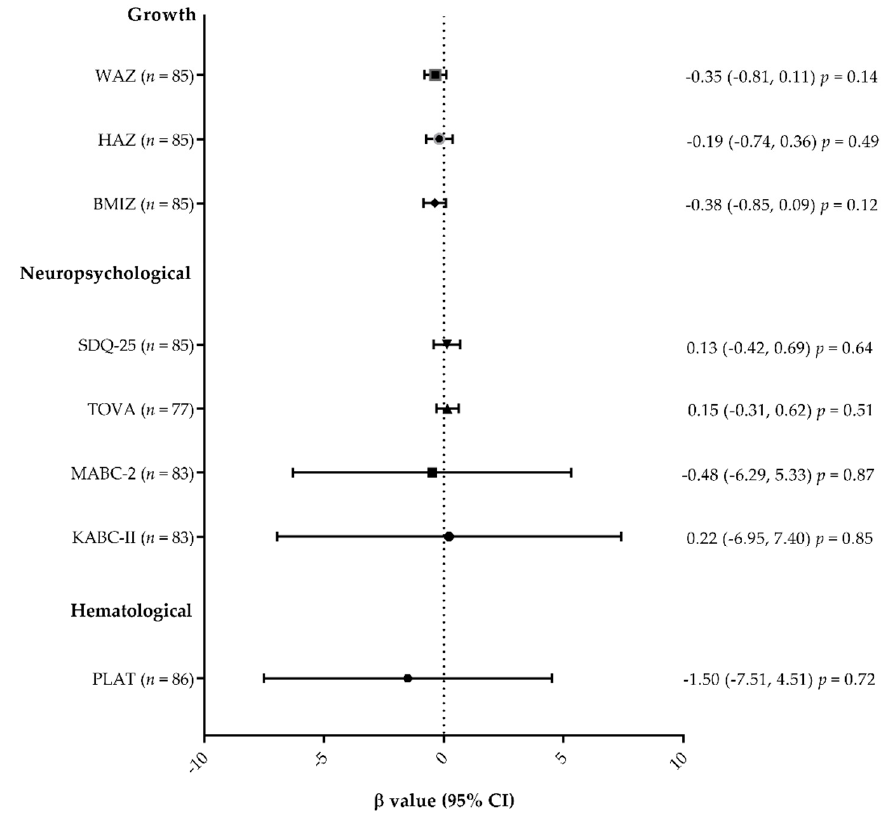
Figure 1. Forest plot of the association between anthropometric, hematological, and neuropsychological outcomes at year 6 with CHEU having a mtDNA depletion at week 50, using linear regressions. β values and confidence intervals are shown. Analyses were adjusted for gender and prophylactic treatment regimen. Abbreviations: WAZ, weight-for-age z-score; HAZ, height-for-age z-score; BMIZ, body mass index z-score; SDQ-25, Strengths and Difficulties Questionnaire;